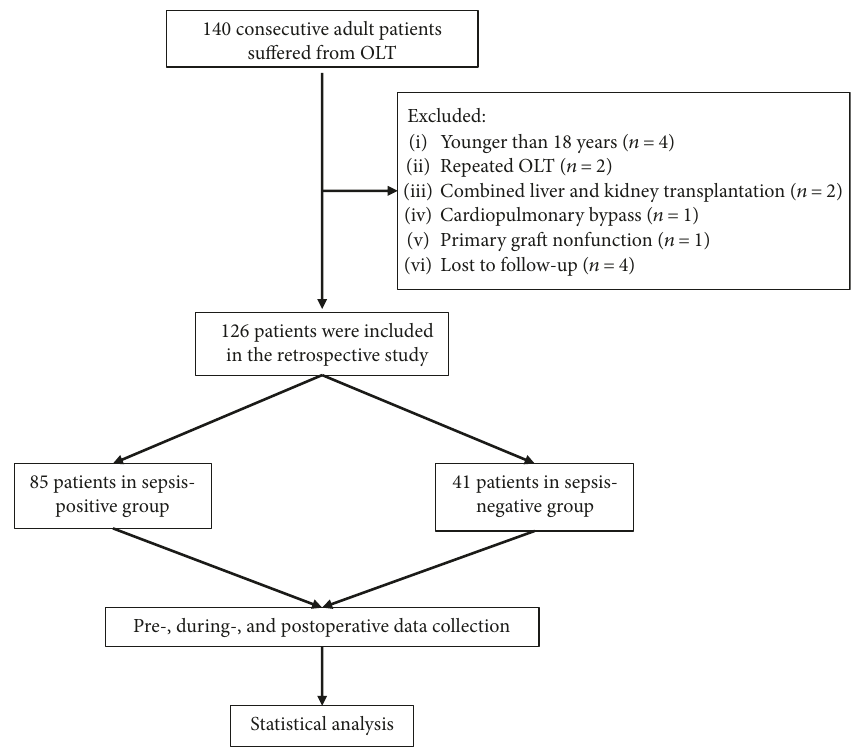
Figure 1: Study population and exclusion criteria in the current retrospective study. Table 1: The major pathogens for sepsis after orthotopic liver transplantation